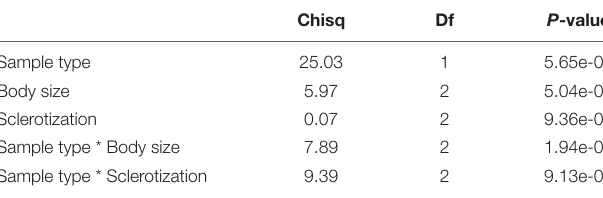
TABLE 3 | The effect of sample type, body size, and sclerotization on the probability of detecting macrobenthos species. Chisq Df P